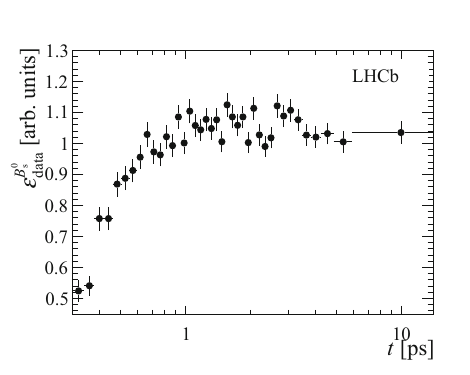
Fig. 3 Distribution of m ( e + e − K + π − ) for selected B 0 → J /ψ K ∗ ( 892 ) 0 candidates divided into three categories: a zero, b one and c both electrons with bremsstrahlung correction. The blue solid line shows the total fit which is composed of (red short-dashed line) the signal and the background contributions. The combinatorial background is indicated by the green long-dashed line while the partially reconstructed background from the B 0 → ψ( 2 S ) K ∗ ( 892 ) 0 , B 0 → χ c 1 ( 1 P ) K ∗ ( 892 ) 0 and B 0 → J /ψ K 1 ( 1270 ) 0 decays are indicated by pink, purple and yellow dash-dotted lines, respectively